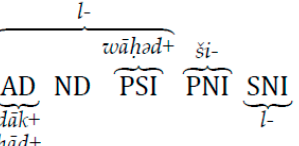
Figure 13. Reference Hierarchy for Moroccan varieties.